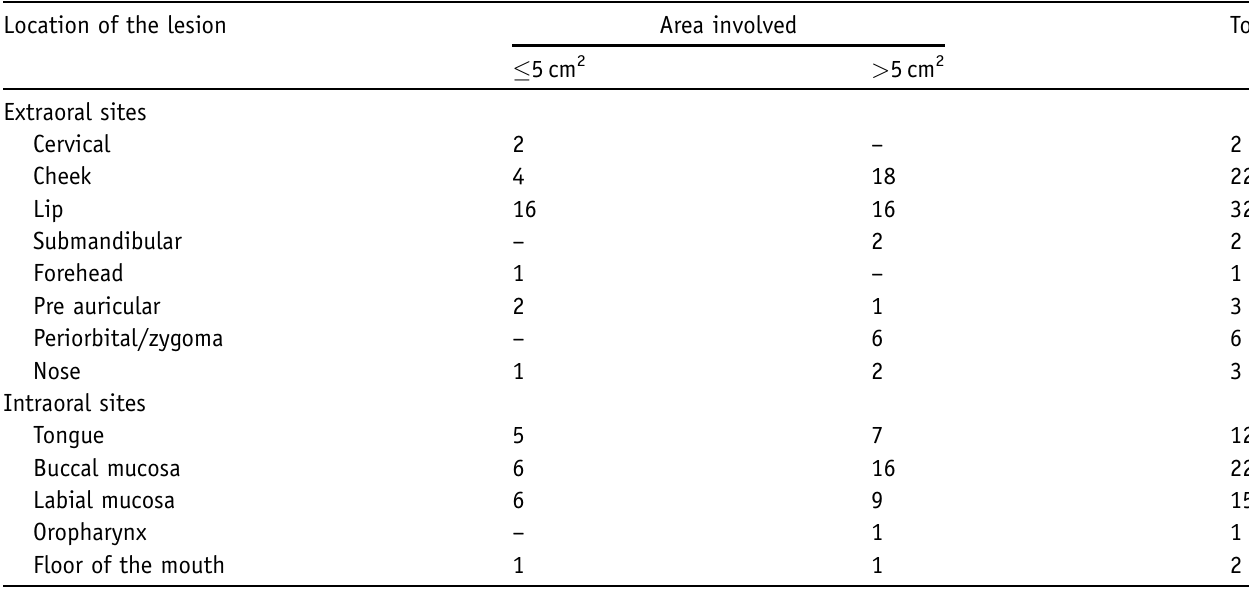
Table I. Anatomical location of head and neck hemangiomas in relation to the total area of the lesion. Location of the lesion